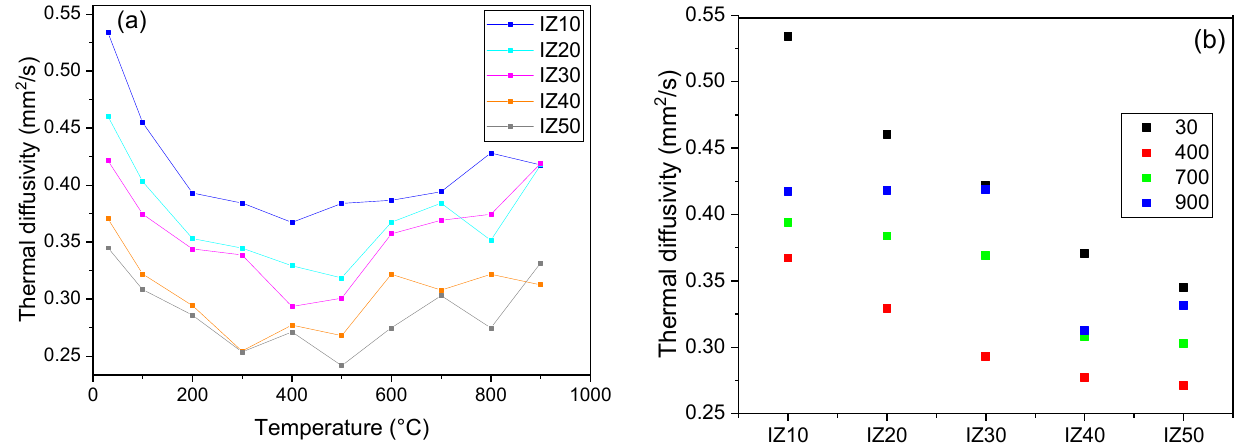
Figure 9. Thermal diffusivity of the mixtures ( a ). Comparison of thermal diffusivities at different temperatures ( b ).